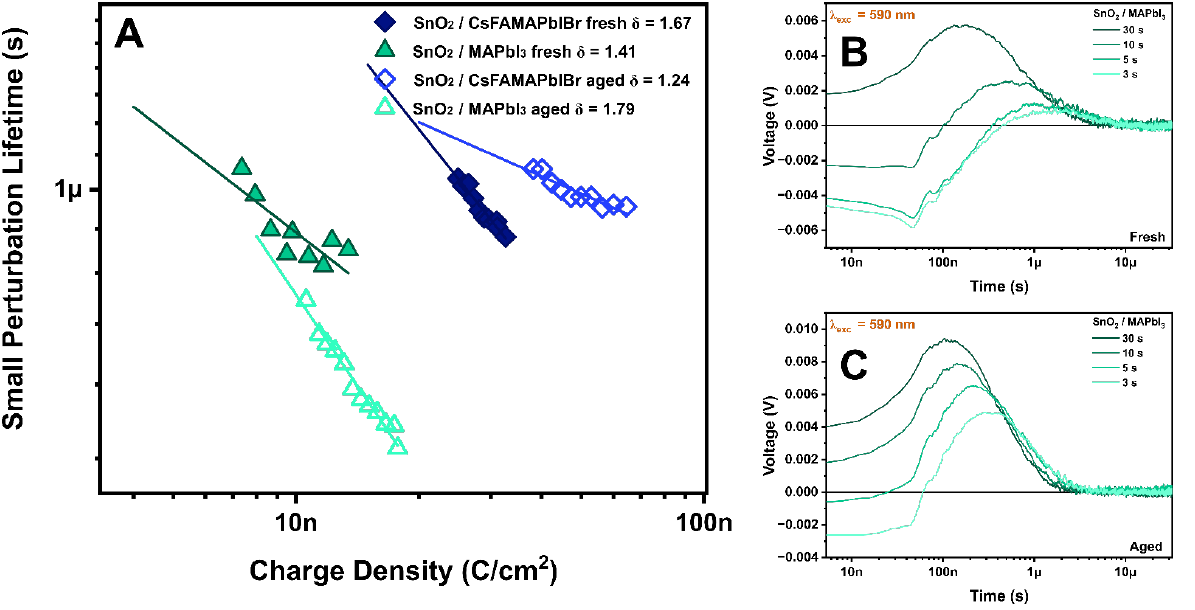
Figure 6. Carrier lifetime obtained from TPV decays as a function of the carrier density after the subtraction of the geometric capacitance for SnO 2 /CsFAMAPbIBr and SnO 2 /MAPbI 3 samples ( A ). TPV decays obtained during different times of illumination for fresh ( B ) and aged ( C ) SnO 2 /MAPbI 3.